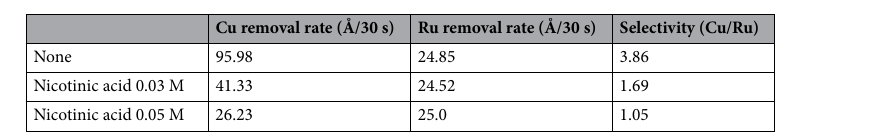
Table 3. Results of the removal rate and selectivity between Cu/Ru films according to inhibitor